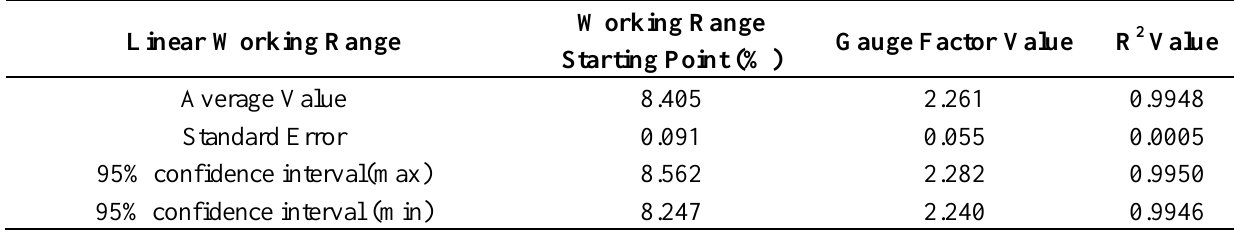
Table 3. Statistical results from the Type 1 sensor.